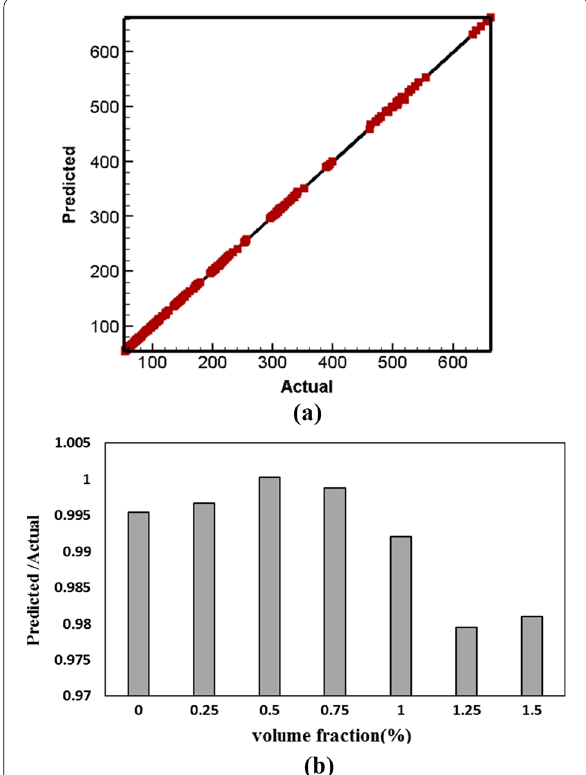
Fig. 19 a Comparison of GPR model results with experimental data, and b ratio of the predicted viscosity to the actual state in T and SR 1739.2 s − 1 in terms of = 46 °C and =